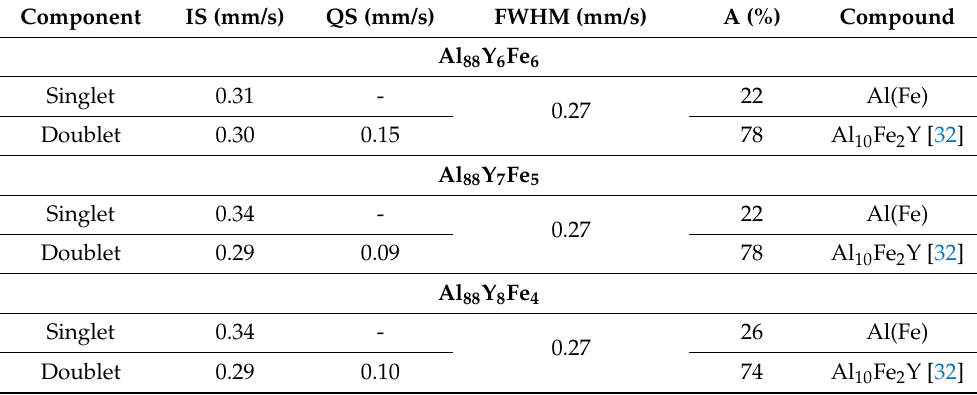
Figure 5. Mössbauer spectra of Al 88 Y 8 Fe 4 , Al 88 Y 7 Fe 5 , and Al 88 Y 6 Fe 6 alloys in the form of ingots. Table 1. Hyperfine parameters of Al 88 Y 8-x Fe 4+x (x = 0, 1, 2 at.%) alloys in ingot states (IS = isomer shift, QS = quadrupole splitting, FWHM = full width at half maximum, A = relative area derived from the